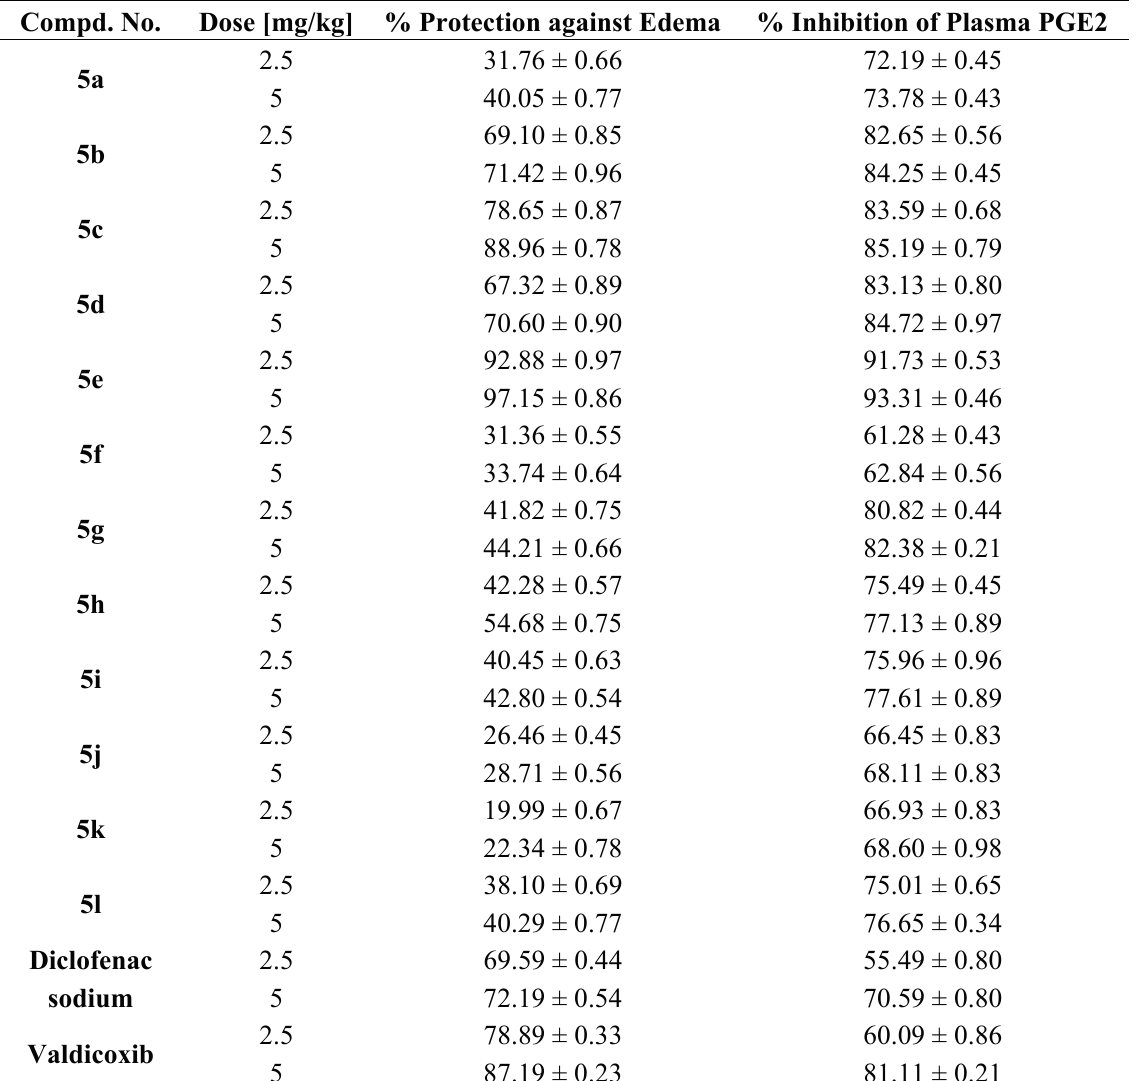
Table 2. Anti-inflammatory